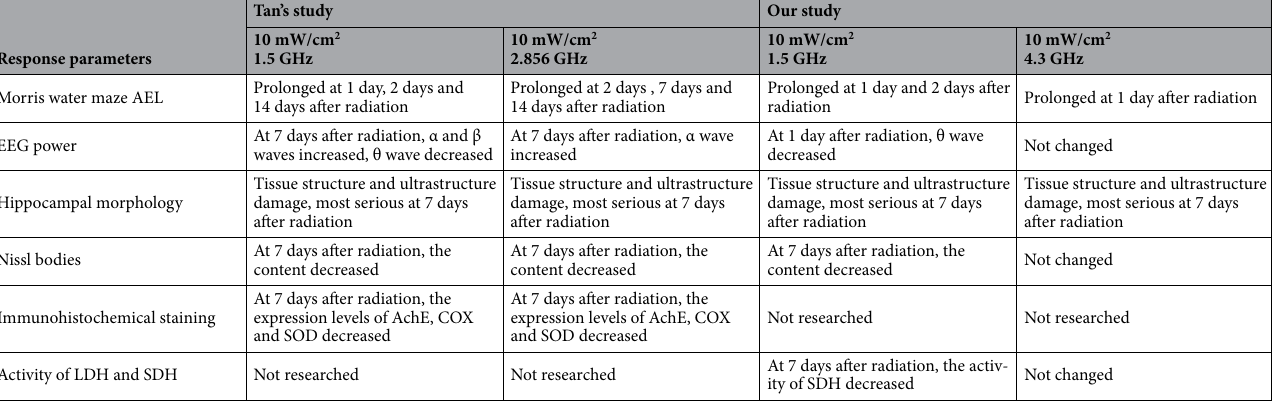
Table 4. Comparison of damage from different microwave